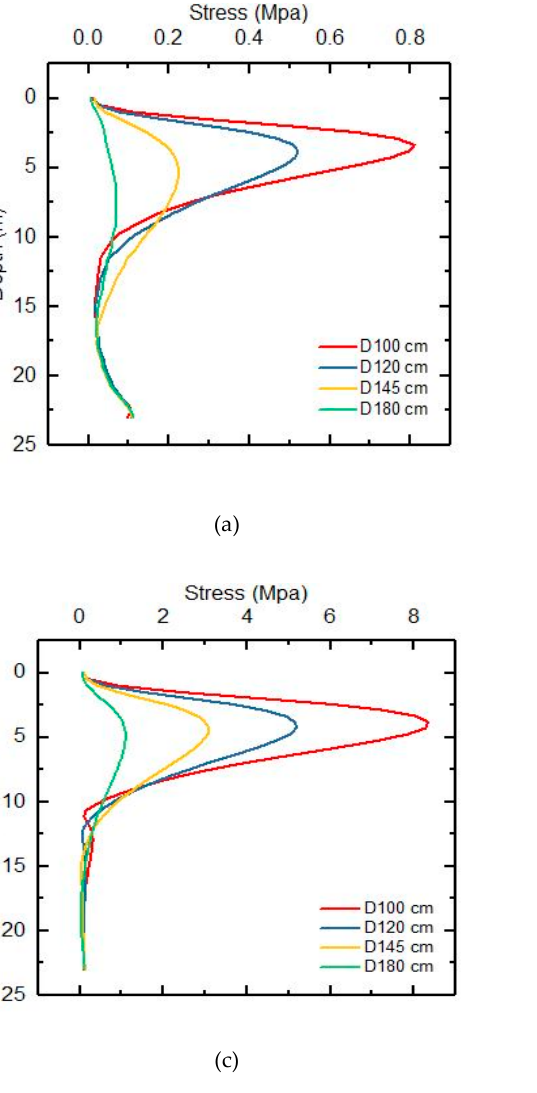
Figure 13. Impact of diameter on the stress distribution along of reinforced concrete pile; ( a ) The stress of the pile in the function of di ff erent diameters at load 110,000 N; ( b ) The stress of the pile in the function of di ff erent diameters at load 440,000 N; ( c ) The stress of the pile in the function of di ff erent diameters at load 1,100,000 N; ( d ) The stress of the pile in the function of di ff erent diameters at load 1,650,000